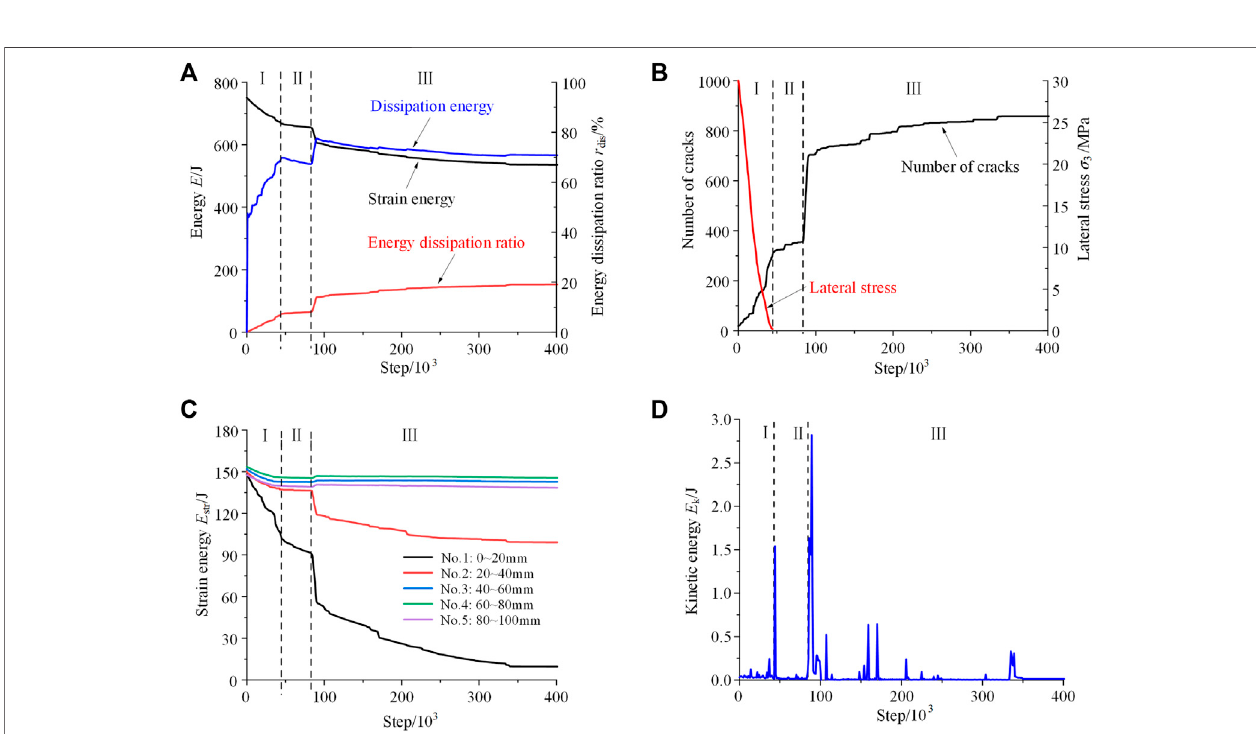
FIGURE2| Energyreleaseprocessofunloadinggranite. (A) Energyofthewholespecimen; (B) crackandlateralstress; (C) energyreleasedindifferentgroups; (D) kinetic energy.